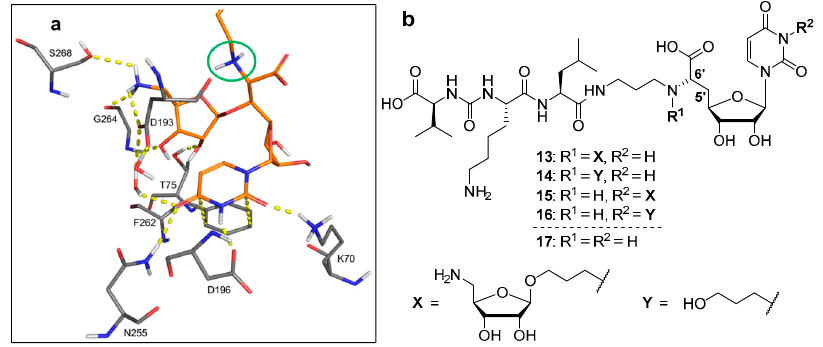
Figure 2. ( a ) Insights into the X-ray co-crystal structure of MraY from Aquifex aeolicus in complex with muraymycin D2 9 (PDB 5CKR) [46,47]: protein-inhibitor interactions at the nucleoside binding site